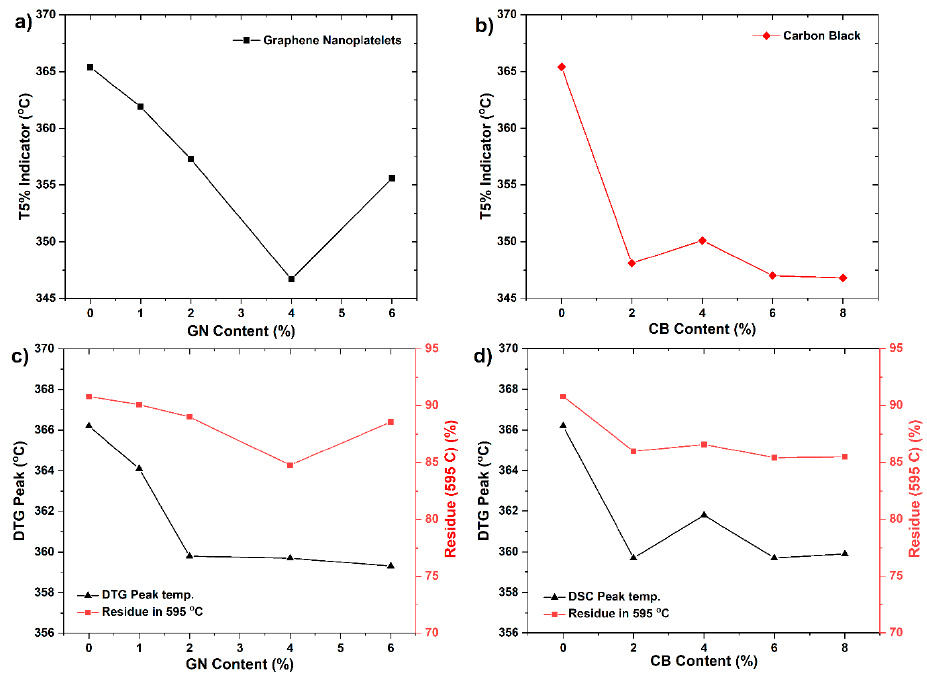
Figure 8. T5% indicator of composites with GN ( a ) and CB ( b ); decomposition peak and solid residue at 595 °C of composites with GN ( c ) and CB ( d ).